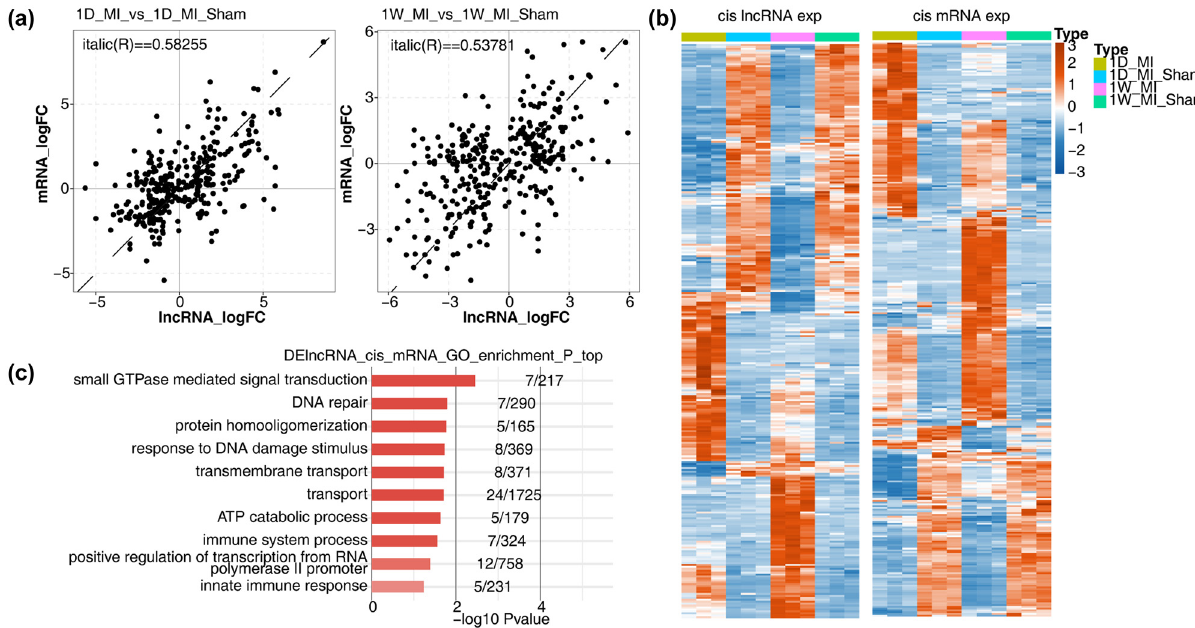
Figure 7: Cis - regulatory genes of DE lncRNAs. ( a ) Scatter plot shows log2 FC of DE lncRNAs by MI compared with Sham samples and its cis - regulatory genes. ( b ) Heatmap shows expression pattern of DE lncRNAs and its cis - regulatory genes. ( c ) Top 10 most enriched GO biological process pathways of cis - regulatory